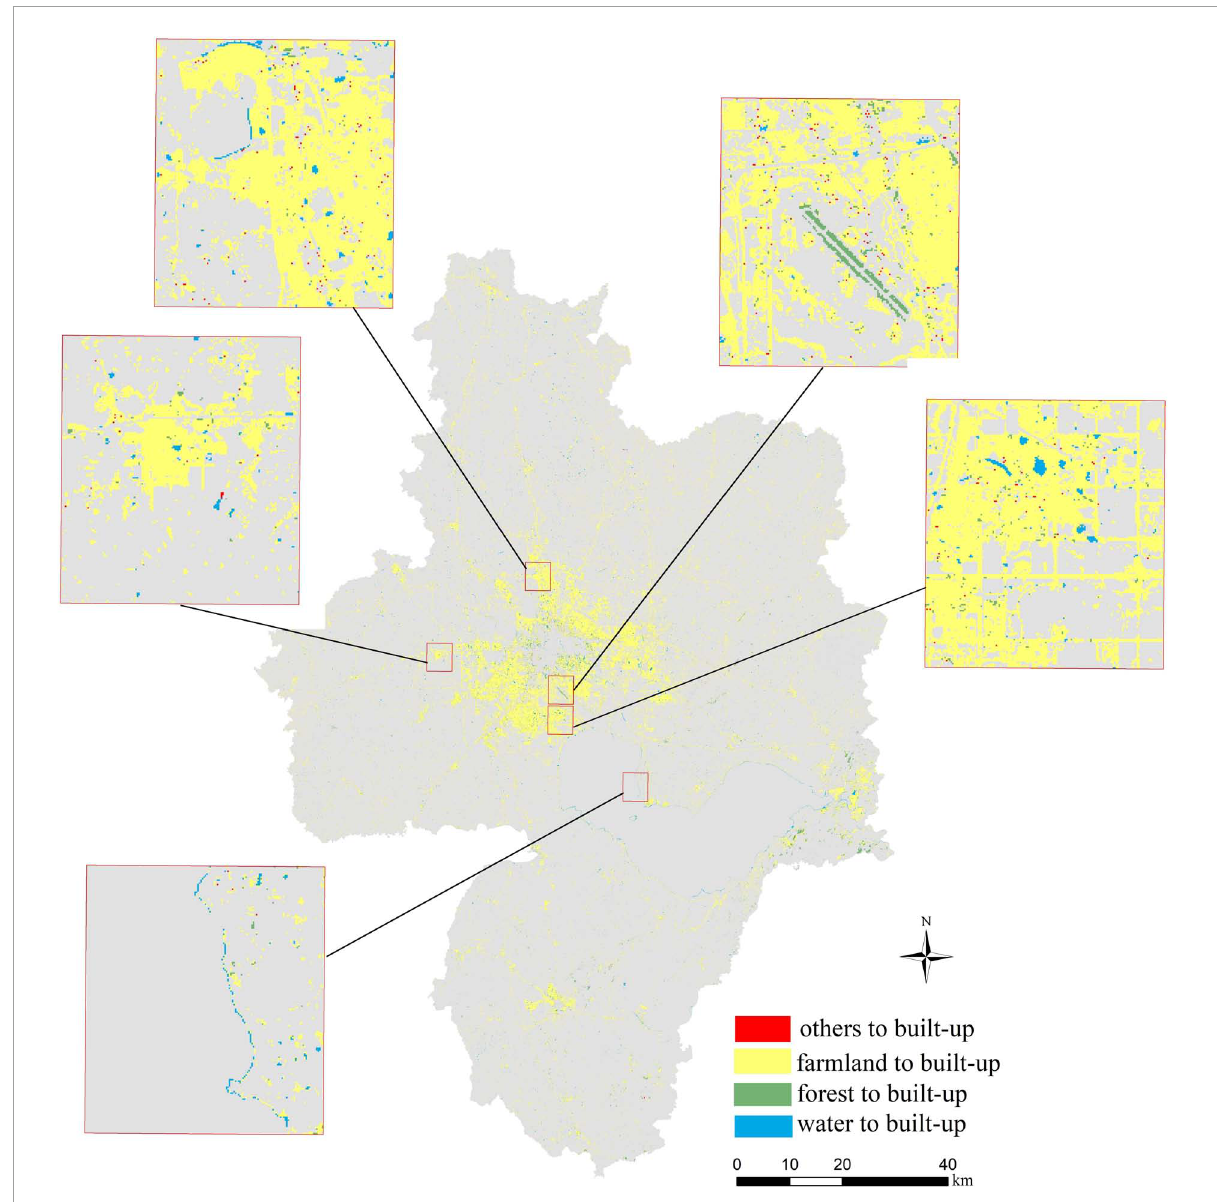
FIGURE4 Spatial transitions from the green space to the built-up area in